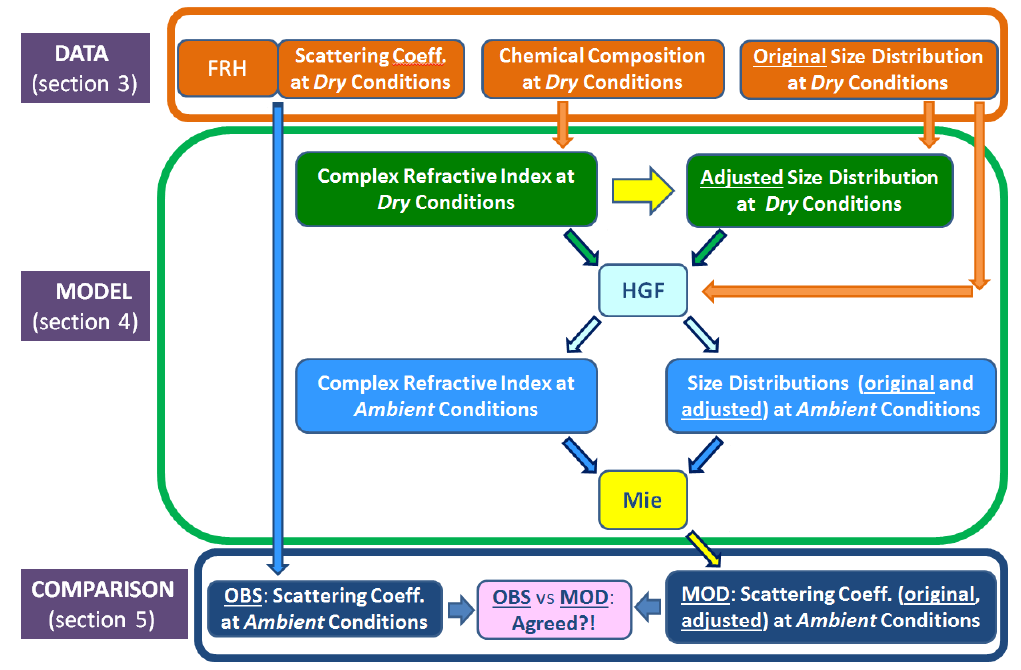
Figure 1. Schematic diagram summarizing the framework for an optical closure experiment using airborne data. The figure illustrates the link between the measured dry and ambient scattering coefficients ( left part of diagram; top and bottom panels) and the connection between the measured dry chemical composition/size spectra and the calculated ambient scattering coefficient ( center and right parts of diagram). Ambient size spectra (light blue, right) are obtained from the dry size distributions without (orange) and with (green) the RI-based correction, respectively. The estimated ambient size spectra (light blue, right) together with the ambient RI (light blue, left) are required as input for Mie calculations (yellow) of the corresponding total scattering coefficients (navy blue, right). See indicated text section for details of each component (Data, Model,